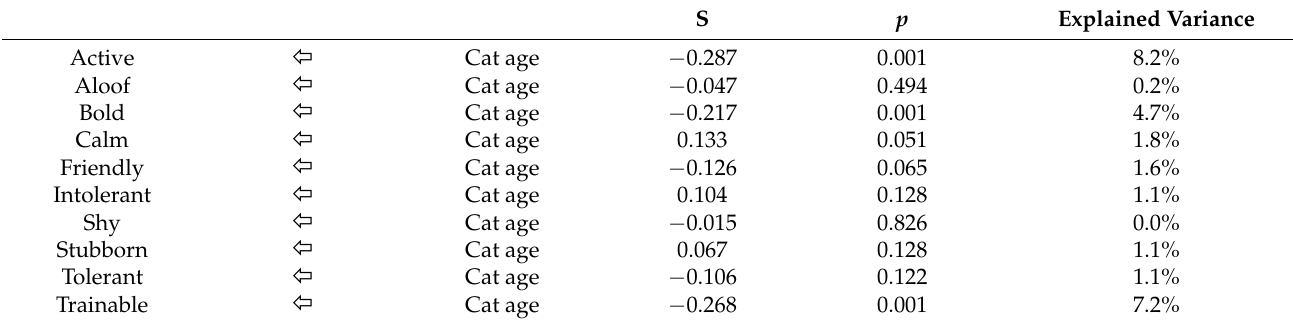
S = Standardized estimates; p = Statistical significance.